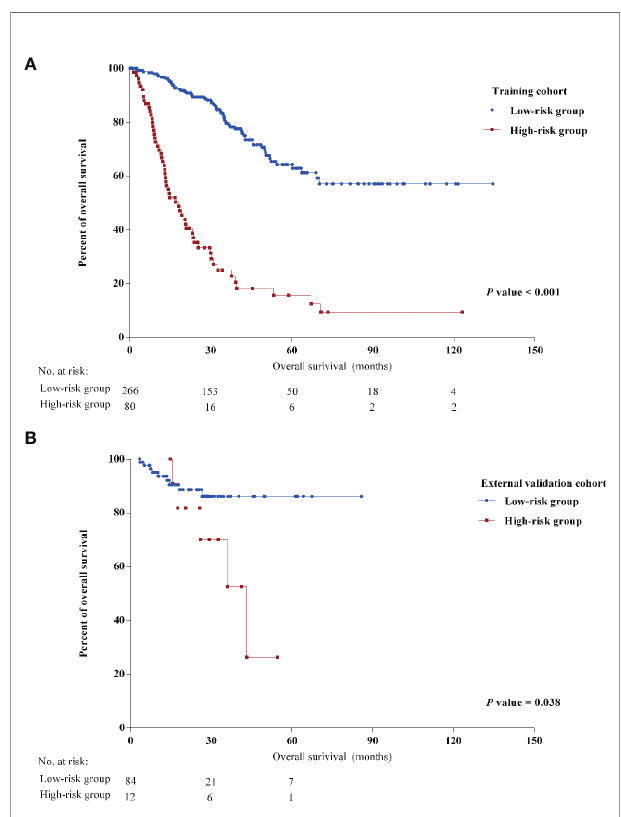
FIGURE 2 | Kaplan-Meier curves of overall survival (OS) of different risk groups in (A) the training cohort and (B) the external validation